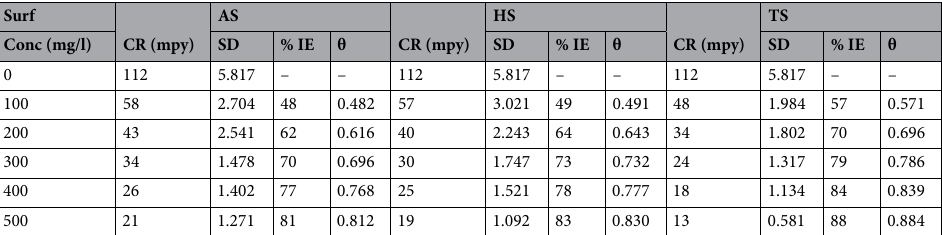
Table 1. Values of copper CRs in 1.0 M H 2 SO 4 solution, % IEs and θs of the examined surfactants at 298 K. AS sodium N-dodecyl asparagine, HS sodium N-dodecyl histidine, TS sodium N-dodecyl tryptophan, CR corrosion rates, % IE inhibition efficiency.